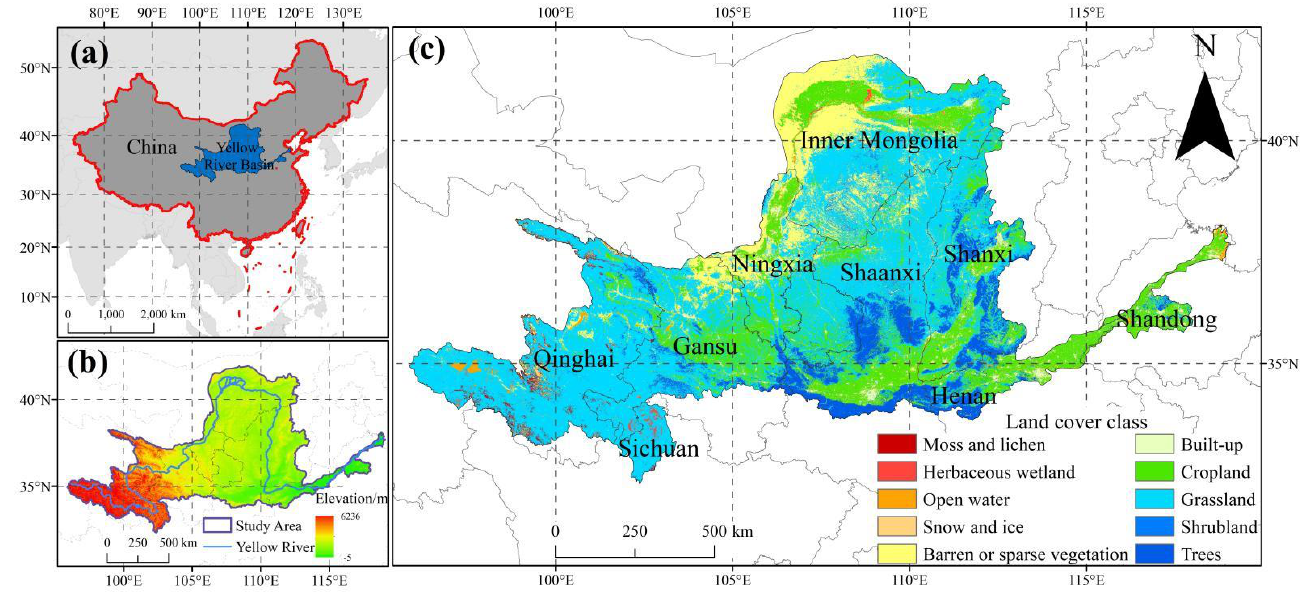
Figure 1. The study area in the YRB: ( a ) location in China, ( b ) elevation, and ( c ) land-cover class.